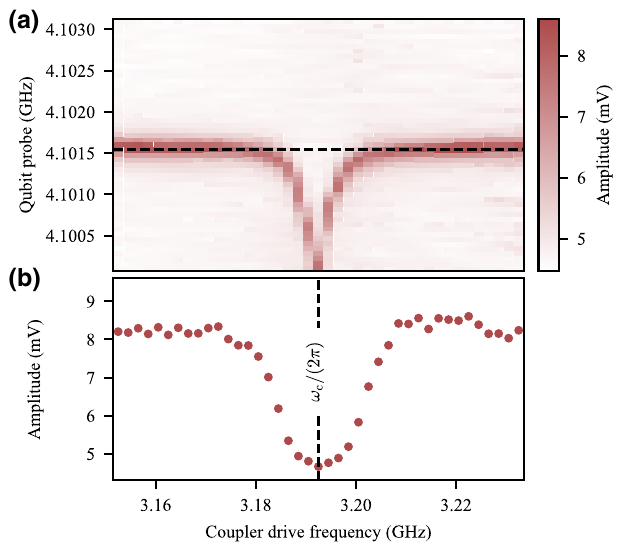
FIG. 10. The results from a three-tone spectroscopy experi- ment. (a) Qubit spectroscopy with an additional frequency sweep of the coupler drive. The horizontal black dashed line indicates the one-dimensional sweep for a three-tone experiment shown in (b). The coupler frequency ω c / 2 π is extracted by a minimum search of the one-dimensional sweep (vertical black dashed